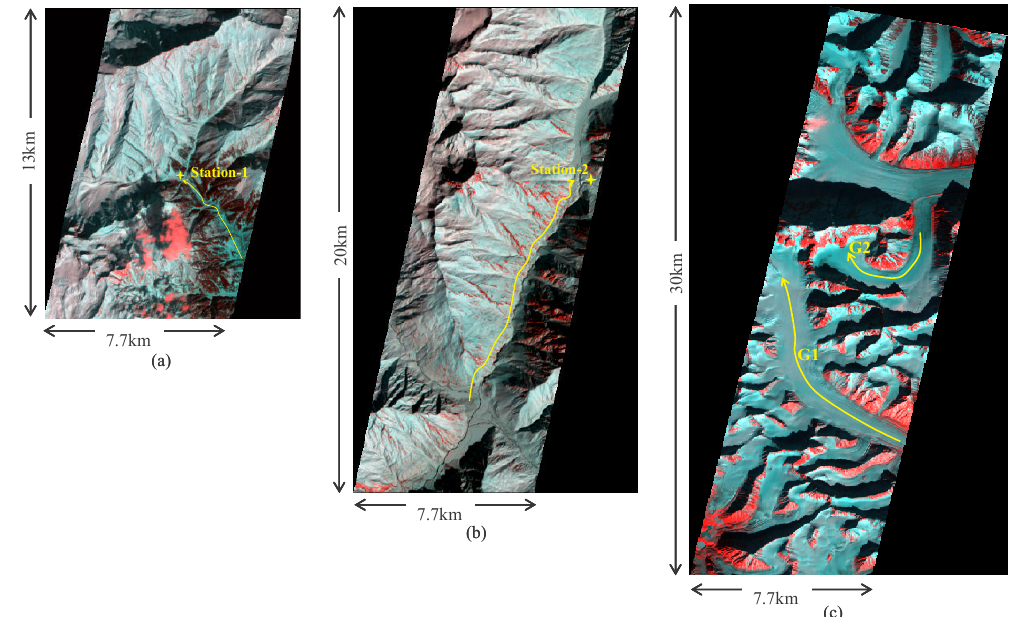
Fig. 2. The Hyperion images (FCC 440:500:1650nm) of study area for the part of (a) lower Himalaya, (b) middle Himalaya and (c) upper Himalaya, with field stations and line drawn for spatial profile (yellow). The lengths of scenes marked are standard length and width of selected areas and the position of each scene is shown in Fig. 1b.